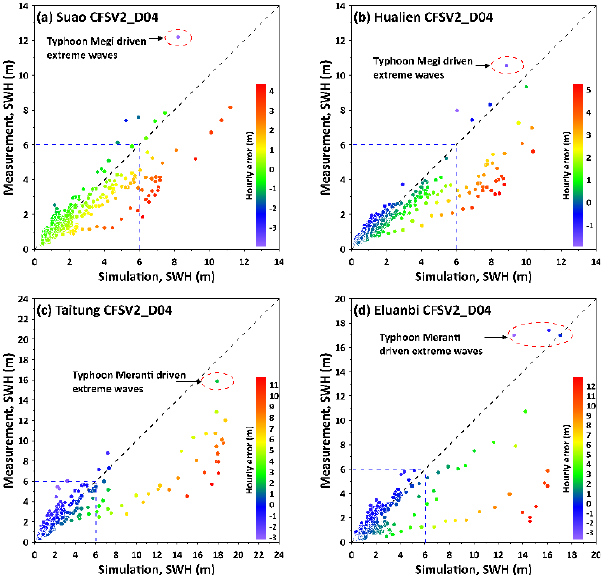
Figure 4. Hourly differences in significant wave height between the measurement and simulation data for the ( a ) Suao, ( b ) Hualine, ( c ) Taitung, and ( d ) Eluanbi wave buoys employing D04 (domain 04) and the SCHISM-WWM-III with CFSV2 winds.